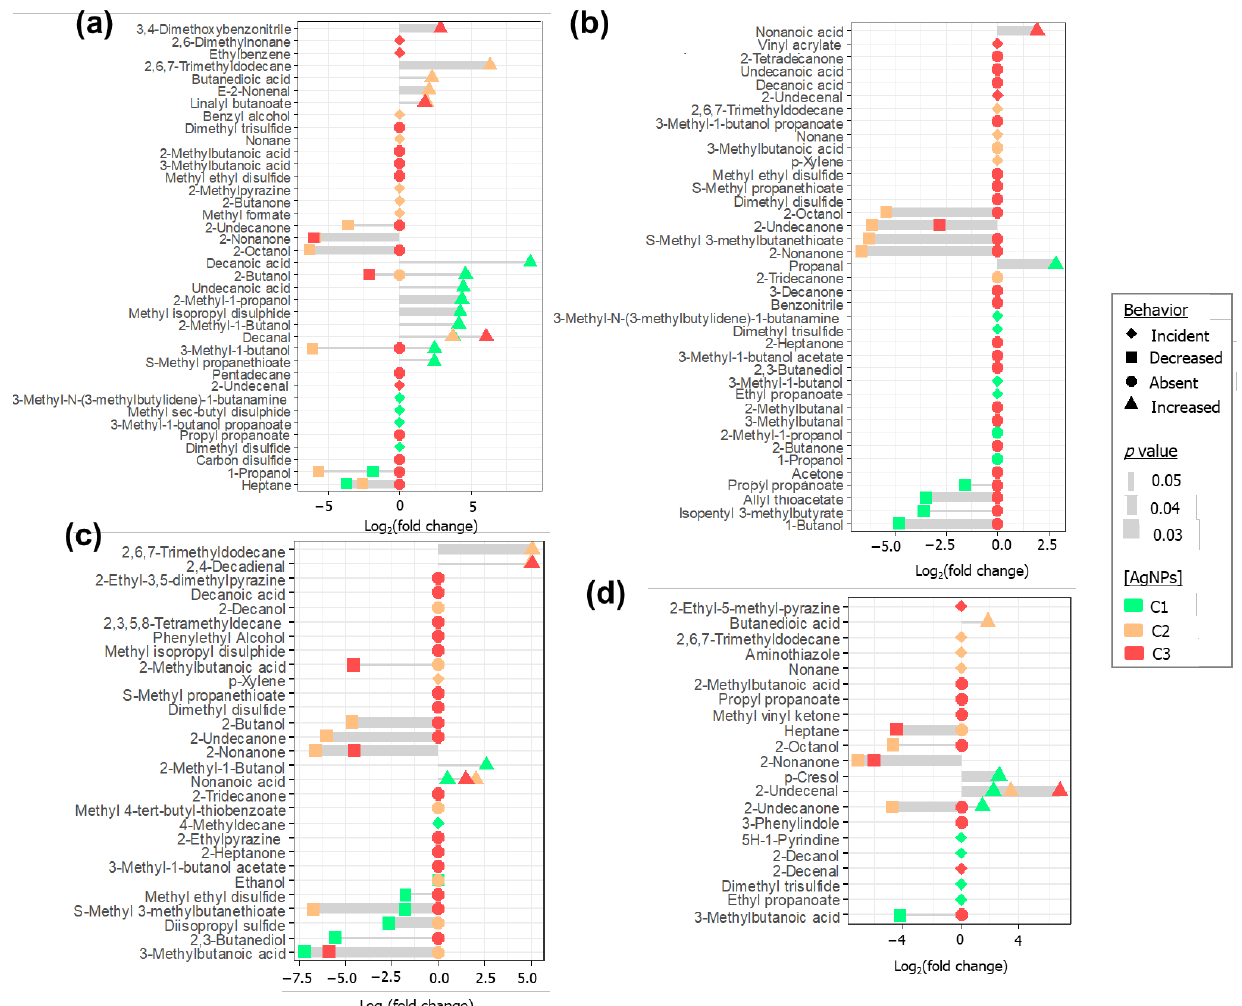
Figure 6. Plots showing alterations in VOCs’ response in treated samples in relation to untreated ones (expressed in terms of binary logarithm of fold change) for ( a ) E. coli , ( b ) K. pneumoniae , ( c ) P. mirabilis and ( d ) E. faecalis . Thickness of the edges are proportional to the significance of the alteration (based on p value). Four main compound behaviors are outlined: incident (diamonds) or absent (circles) only after bio-AgNPs treatment, and those that had increased (triangles) or decreased (squares) responses after the supplementation. C1, C2 and C3 = supplementation with bio-AgNPs at 12.5, 25 and 50 µg mL −1 , respectively.